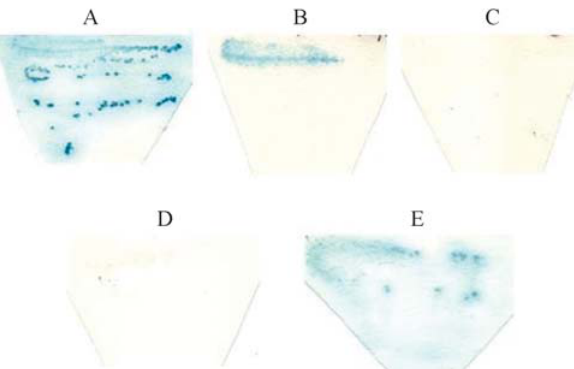
Figure 2 - Transcriptional activation in the X-gal filter assay. Y190 transformant cultures carrying plasmids pCL1 ( A ; strong transcriptional activator), pNTmKad4 ( B ; weak transcriptional activator), pGBT9 ( C ; vector), pBDA-2 ( D ; GAL4-BD-mat A-2) or pBDA-3 ( E ; GAL4-BD-mat A-3) were grown on filters laid on solid SD medium lacking tryptophan. Filters were incubated at 37 °C for 4-16 h.